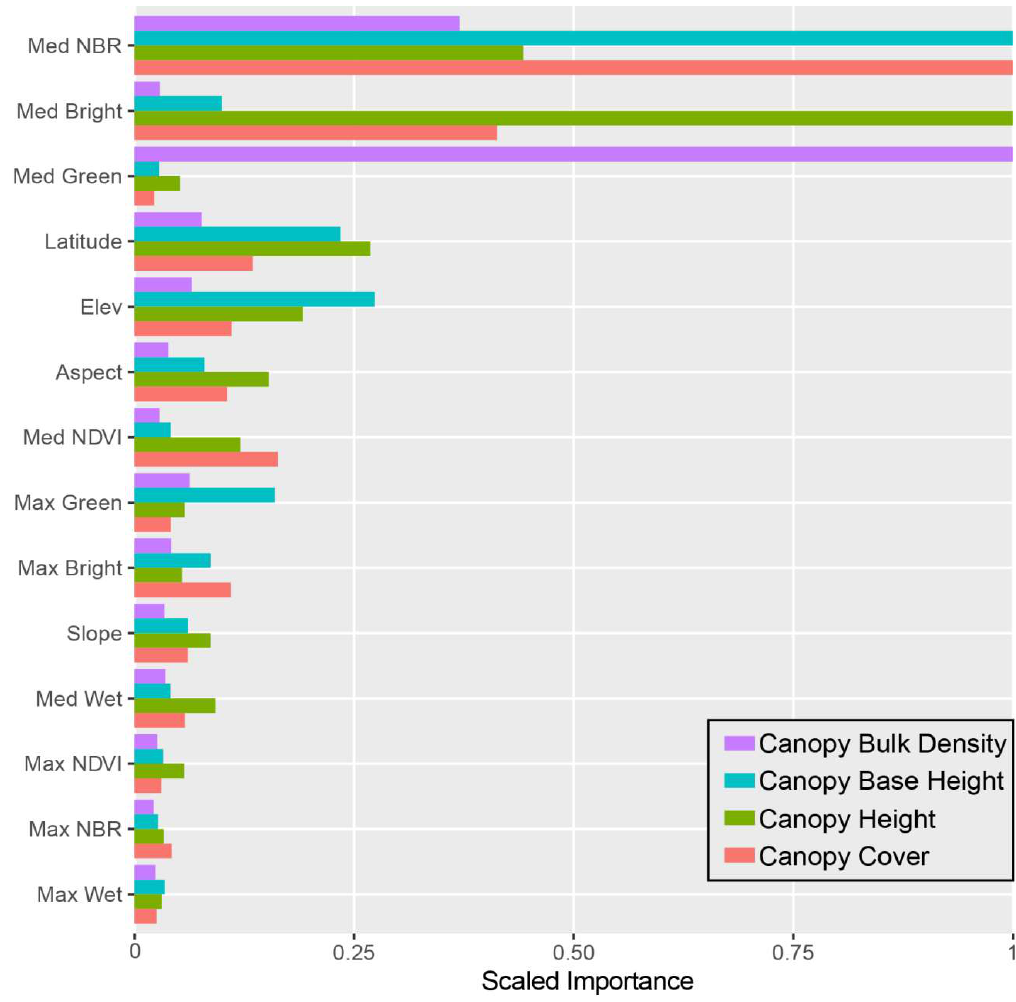
Figure 14. Variable importance for each canopy fuel response variable derived from the global gradient boosting machine (GBM) model using training landscape data.